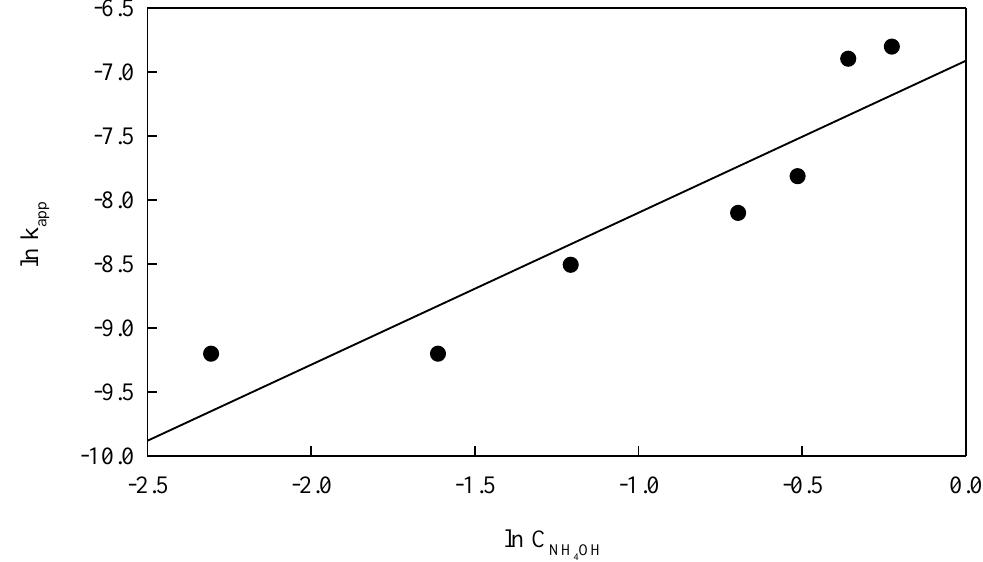
Figure 14. Analysis of the reaction order in relation to the concentration of ammonium hydroxide.